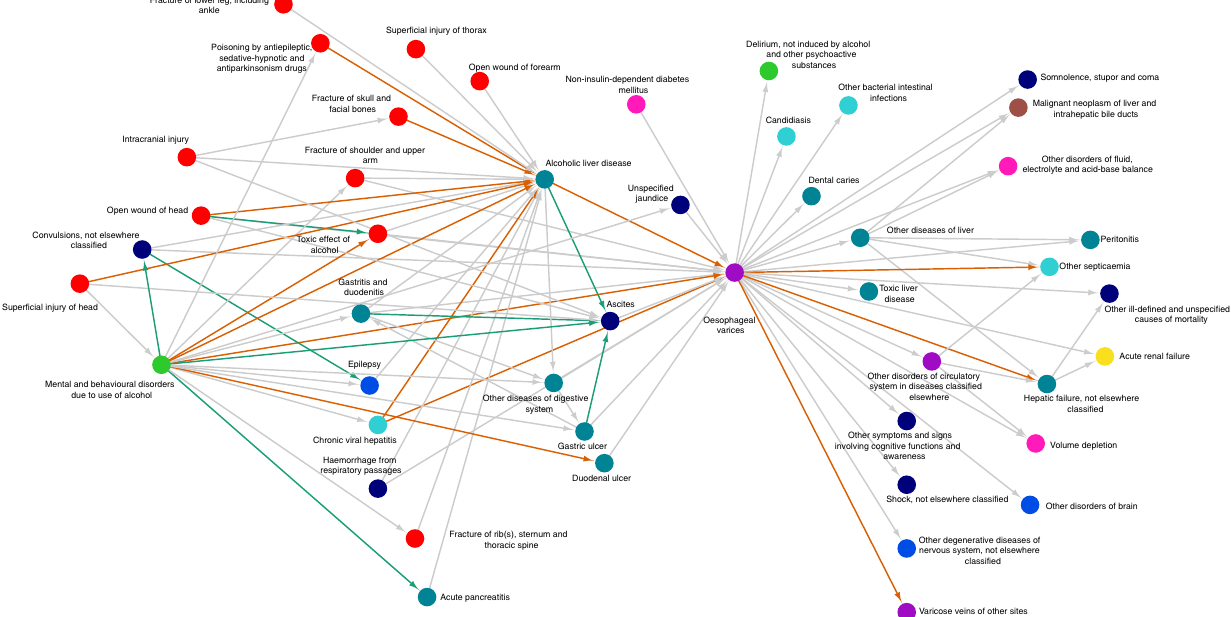
Fig. 5 Diagnosis trajectories involving injury or drug and alcohol abuse. A trajectory network combining 176 linear diagnosis trajectories related to alcohol and substance abuse (ten directional pairs with extreme differences in relative risk). Edges represent the connection between the diagnoses with directional co-occurrence. The orange and green edges between nodes indicate co-occurrences where the RR was elevated in women and men, respectively. The RR of injuries followed by alcoholic liver disease is increased in women. Furthermore, women have a higher RR of complications following esophageal varices, such as hepatic failure. RR relative risk